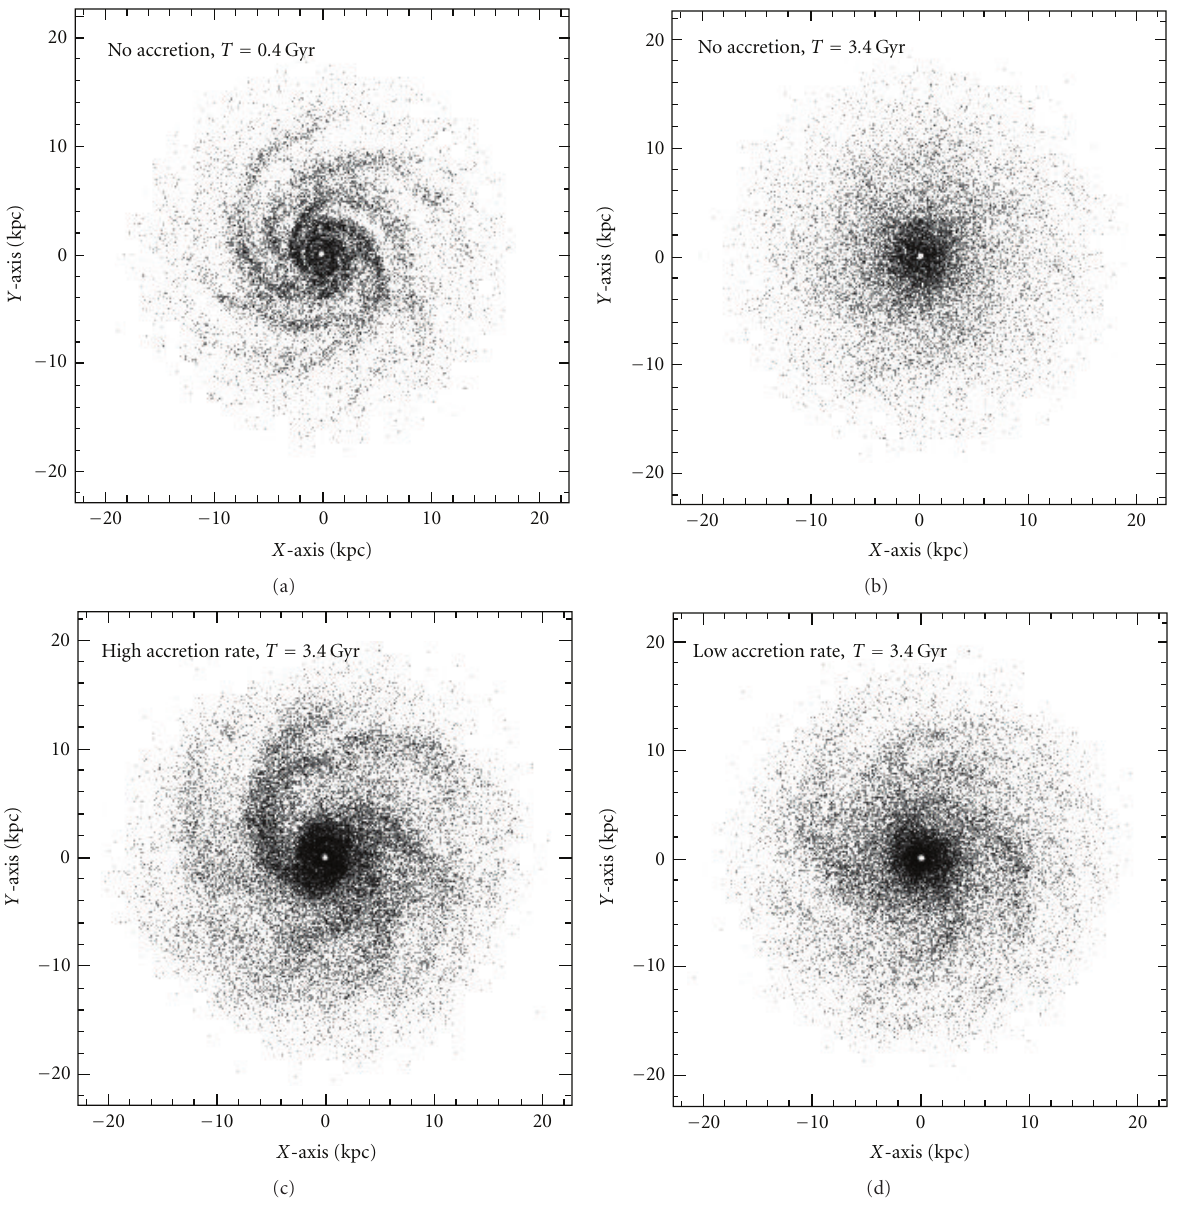
Figure 21: Morphological properties for di ff erent models from [270] with no gas accretion at T = 0 . 4 Gyr (a) and T = 3 . 4 Gyr (b) Models with high (c) and low (d) gas accretion rates. Credit: Bekki et al. [270]. Reproduced by permission from the